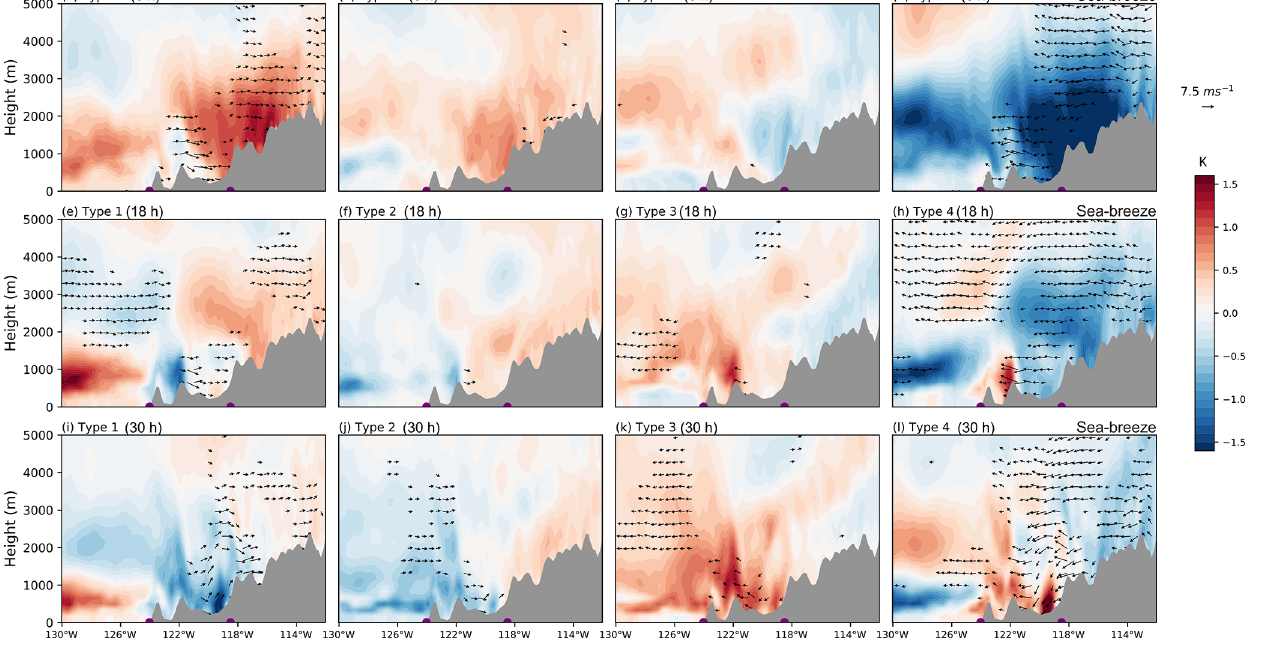
Figure 11. Cross section of anomalous wind (vectors) and temperature (colors) at (a–d) 6h, (e–h) 18h, and (i–l) 30h for each SOM type during the sea-breeze case. The gray area indicates the topography. The location of the cross section is marked in Fig. 10.